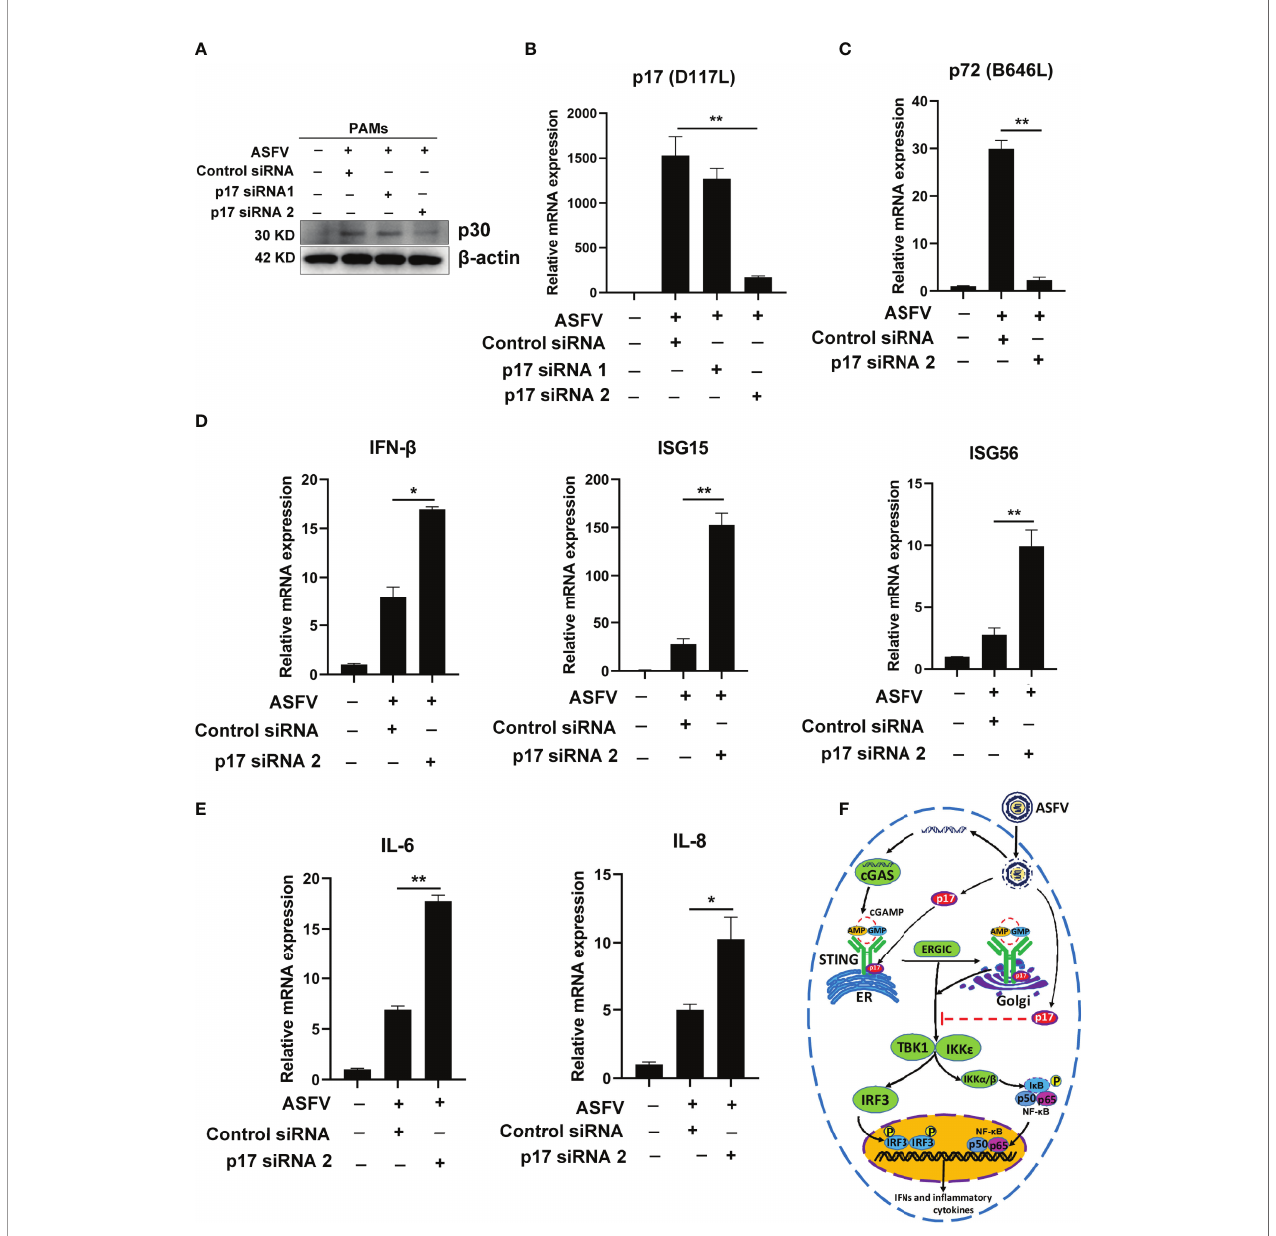
FIGURE 10 | The role of p17 in ASFV caused IFN evasion. Primary PAMs (1×10 6 cells/well) were transfected with various siRNAs (100 nM) for 24h and then infected with 0.01 MOI ASFV for another 72h. (A) The expression of ASFV p30 was detected by using Western blotting. (B, C) The transcriptions of viral p17 (D117L) and p72 (B646L) gene were analyzed by using RT-qPCR. (D, E) The effects of p17 on the host gene transcriptions of IFN- b , ISG15, ISG56, IL-6 and IL-8 induced by ASFV were analyzed by RT-qPCR. (F) The schematic presentation of the molecular mechanism of p17 inhibiting cGAS-STING pathway. Values represent the mean±S.D. * P <0.05, ** P